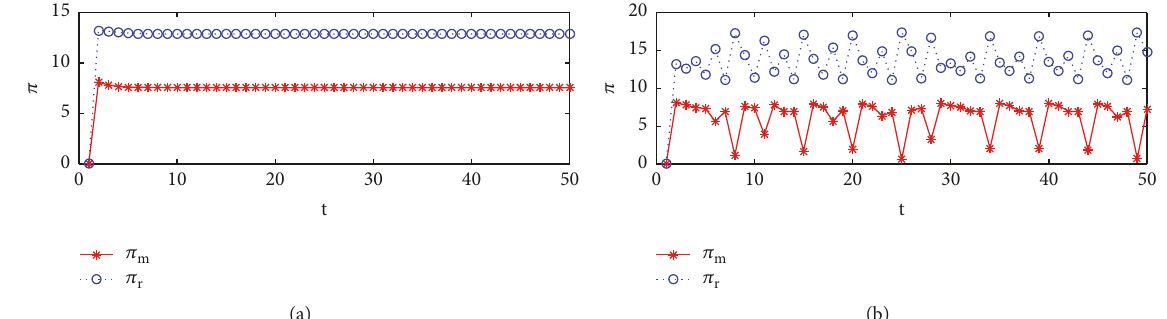
Figure 13: Changes for profits in different periods: (a) steady state; (b) chaotic